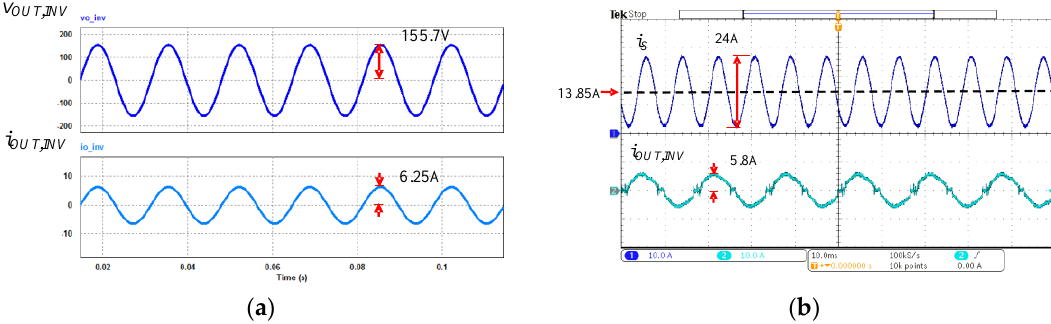
Figure 13. Steady-state of the output voltage and inductor current of the ARF: ( a ) Simulation result and ( b ) experimental result.